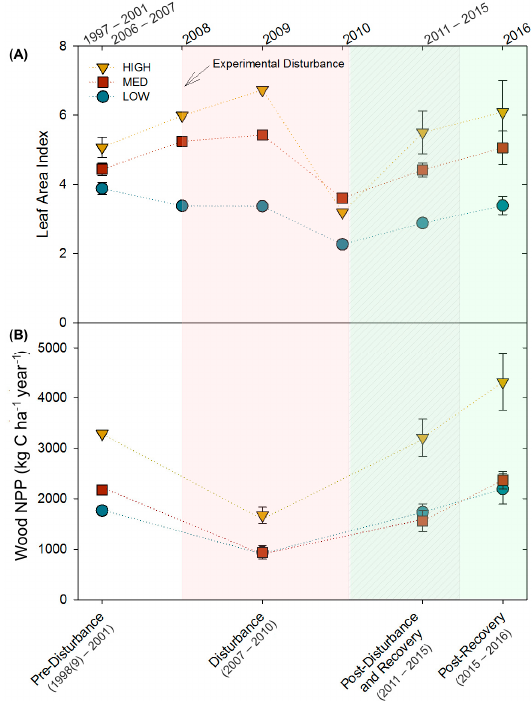
Figure 1. ( A ) Leaf area indices (LAI) and ( B ) wood net primary productivity (wood NPP) for the three 2-ha treatment stands over time. Shaded areas correspond with ecological time periods along the bottom X-axis. When multiple observations were available, values shown represent mean ± SE.